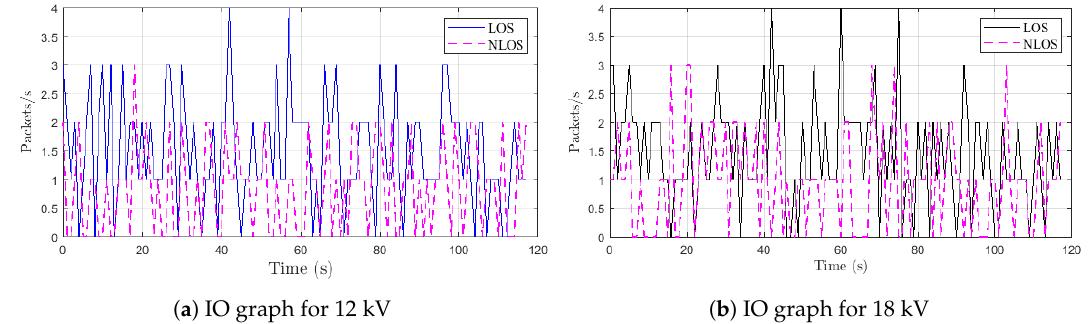
Figure 6. Overall rate of traffic for 12 and 18 kV when the emitter and the receiver are both placed at 1 m from the source.